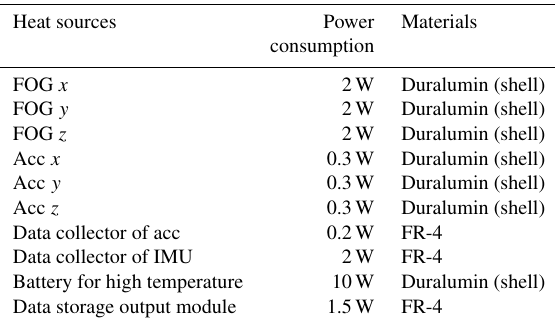
Table 6. The heat consumption table of main heat